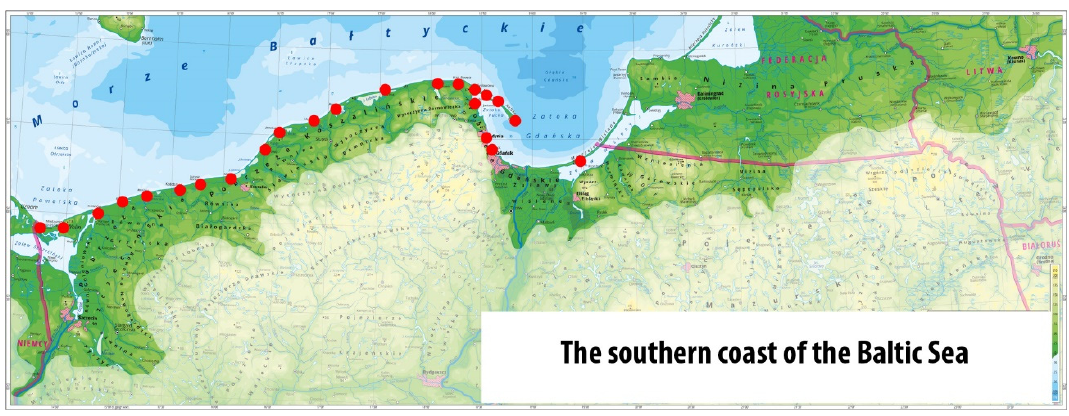
Figure 1. The territorial scope of the research. Source: Authors’ work.